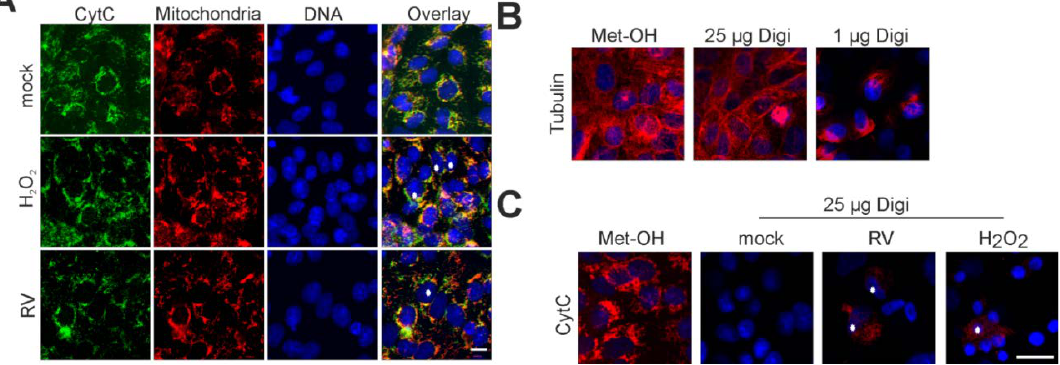
Figure 4. Localization of the mitochondrial death-effector protein cytochrome c under RV infection. ( A ) Immunofluorescence analysis of RV- and mock-infected Vero cells at 3 dpi with anti- CytC antibody (shown in green). As a counterstain, mitochondria were labelled with MitoTracker Red CMXRos (shown in red) before fixation. Nuclear DNA is shown in blue, yellow colour indicates overlap areas. As a positive control, overnight incubation with 0.003% H 2 O 2 was applied; ( B ) Selective permeabilization of the plasma membrane with digitonin was tested for alpha-tubulin (shown in red) as a representative cytoplasmic protein; ( C ) Selective permeabilization with digitonin at 25 μg/mL was applied to mock- and RV-infected Vero cells. Immunofluorescence was performed with anti-CytC antibody (shown in red). Release of CytC was induced through overnight incubation with 0.003% H 2 O 2 . ( B ), ( C ) As a control, immunofluorescence analysis of mock-infected Vero cells was performed after methanol (Met-OH) permeabilization. Asterisks highlight representative cells with localization of CytC outside of mitochondria. Scale bar, 10 μm.